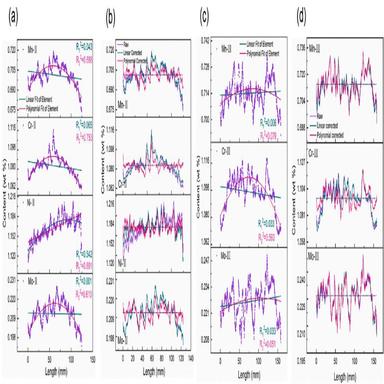
Fitting curve and corrected line distribution for Mn, Cr, Ni, Mo of type II and Mn, Cr, Mo type III in the A11 (a) Type II raw line distribution and fitted curve (b) Type II corrected line distribution (c) Type III raw line distribution and fitted curve (d) Type III corrected line distribution.